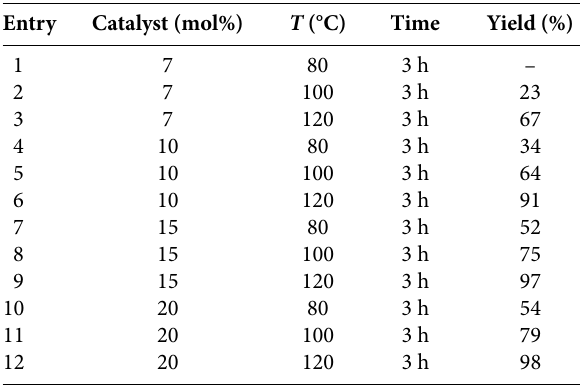
Table 2. Optimization of reaction conditions for preparing 2,4,6-triphenylpyridine